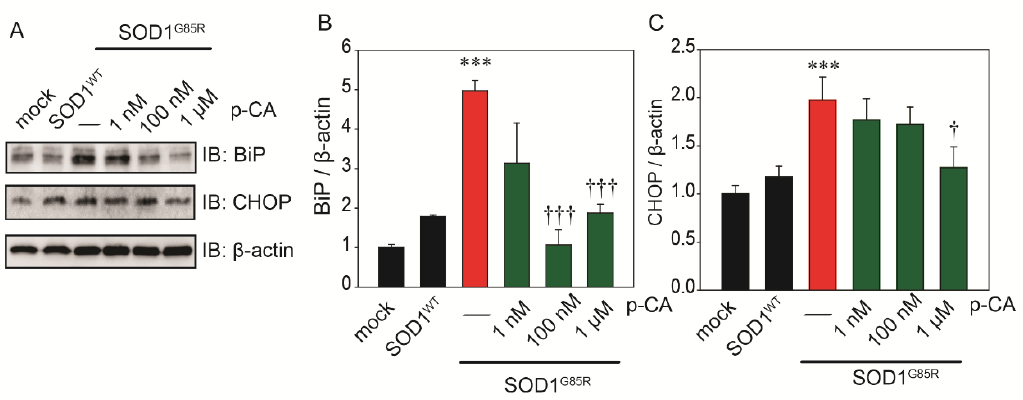
Figure 3. p-CA reduced SOD1 mut -related ER stress. ( A ) Immunoblot analysis of BiP and CHOP relating to ER stress. ( B , C ) Densitometric quantification of BiP ( B ) and CHOP ( C ). Differences were evaluated by one-way ANOVA (mean ± SEM, n = 3). *** p < 0.001 vs. SOD1 WT , ††† p < 0.001, † p < 0.05 vs. SOD1 G85R . p-CA: p-coumaric acid.